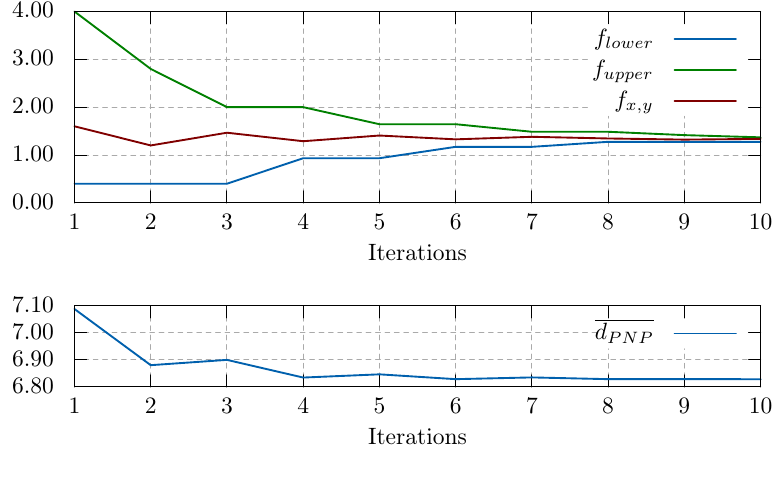
Figure 13. Ternary-search iterations.